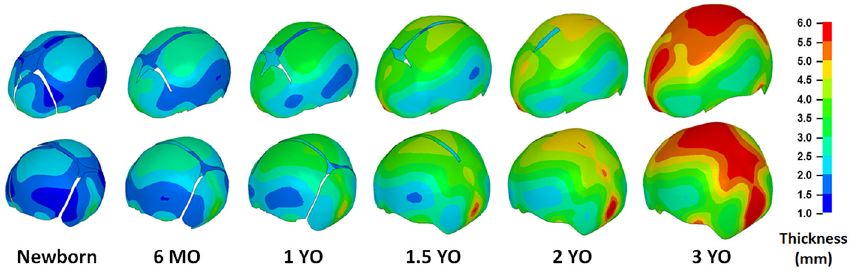
Fig 8. Skull thickness distribution by age. The models shown here were generated by morphing a template mesh into the model-predicted skull geometry using a Radial Basis Function. The color contours were generated based on the skull thickness values associated with each node on the morphed mesh. The quantitative skull thickness data corresponding to each landmark location can be found in Table D in the S1